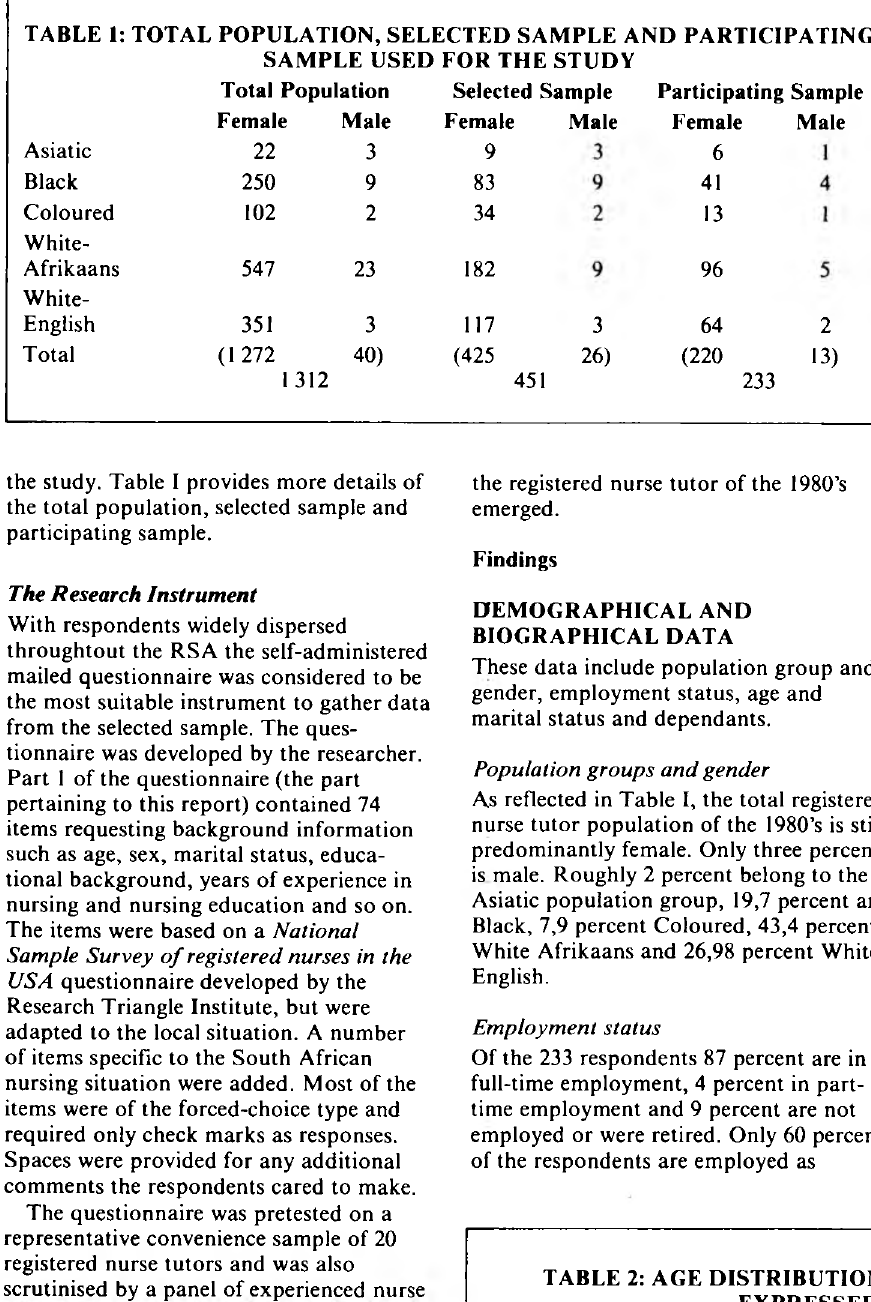
TABLE 3: MARITAL STATUS AND DEPENDANTS OF